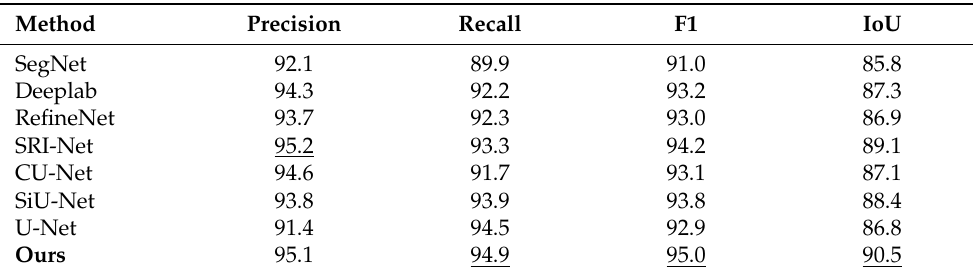
Table 1. Quantitative comparison (%) of several state-of-the-art (SOTA) methods used on the WHU Aerial Building Dataset (the highest values are underlined). The first three methods and SRI-Net were implemented by [4], SiU-Net [5] is the official method provided by the dataset, and the others were implemented by [5].